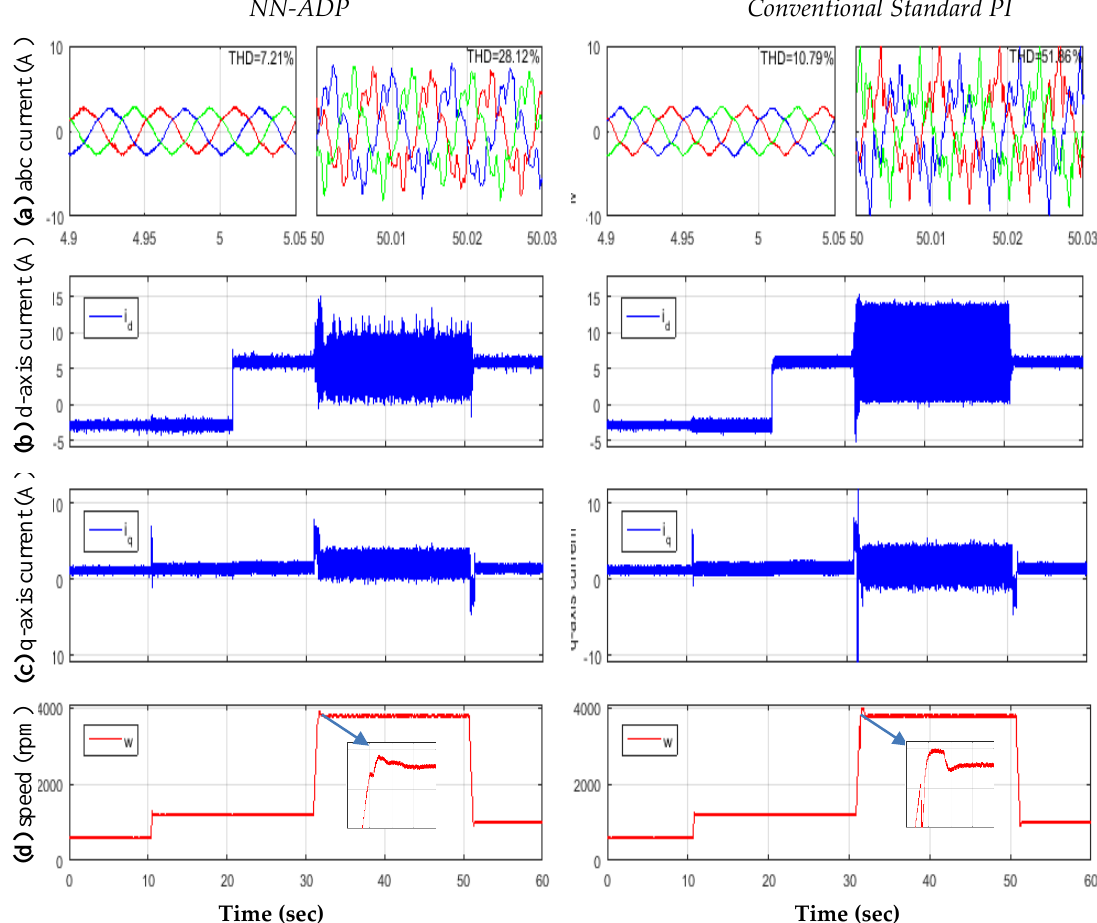
Figure 11. NN vs. conventional IPM motor control comparison: ( a ) three-phase motor current and THD, ( b ) d -axis current, ( c ) q -axis current, and ( d ) motor speed.